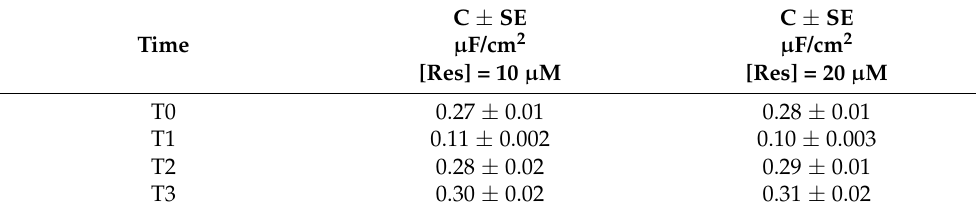
Table 2. Capacitance variation in POPC PLM. Mean values of the membrane capacitance (C ± SE) calculated at T0 (just before the addition of resveratrol), T1 (at the 70% of lag time), T2 (at the end of lag time), and T3 (after an average of 1 h from first channel-like event appearance). The mean value was obtained from at least three